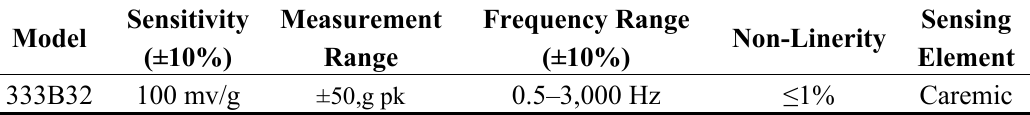
Table 1. The parameters of acceleration sensors.